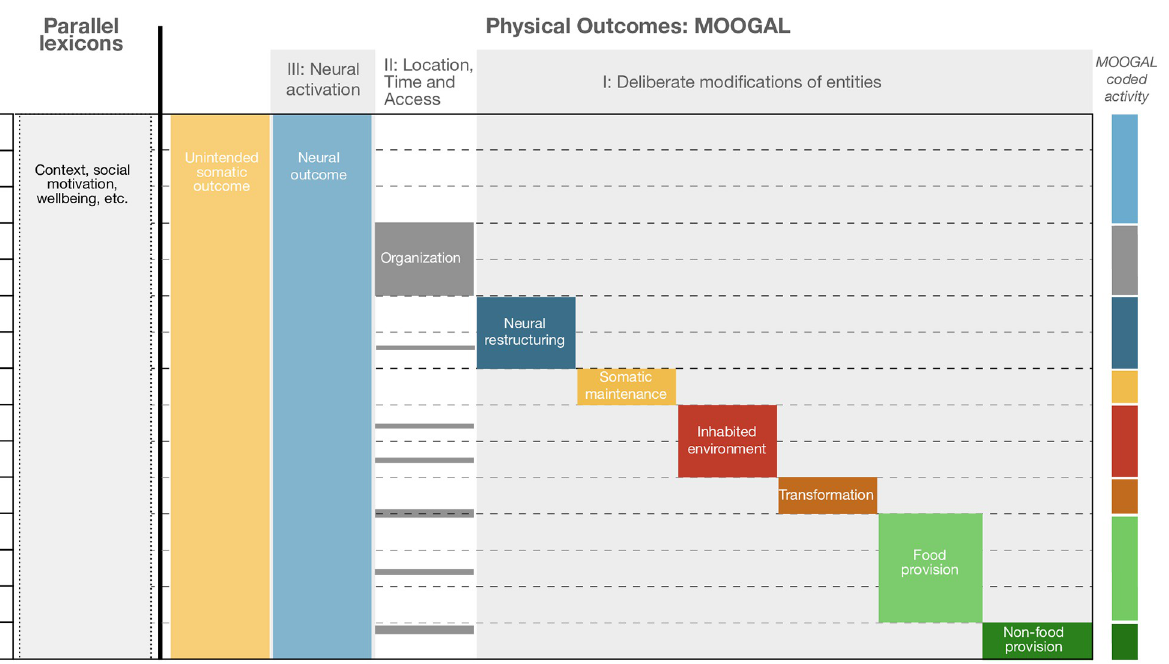
PLOS ONE | https://doi.org/10.1371/journal.pone.0270583 July 14,